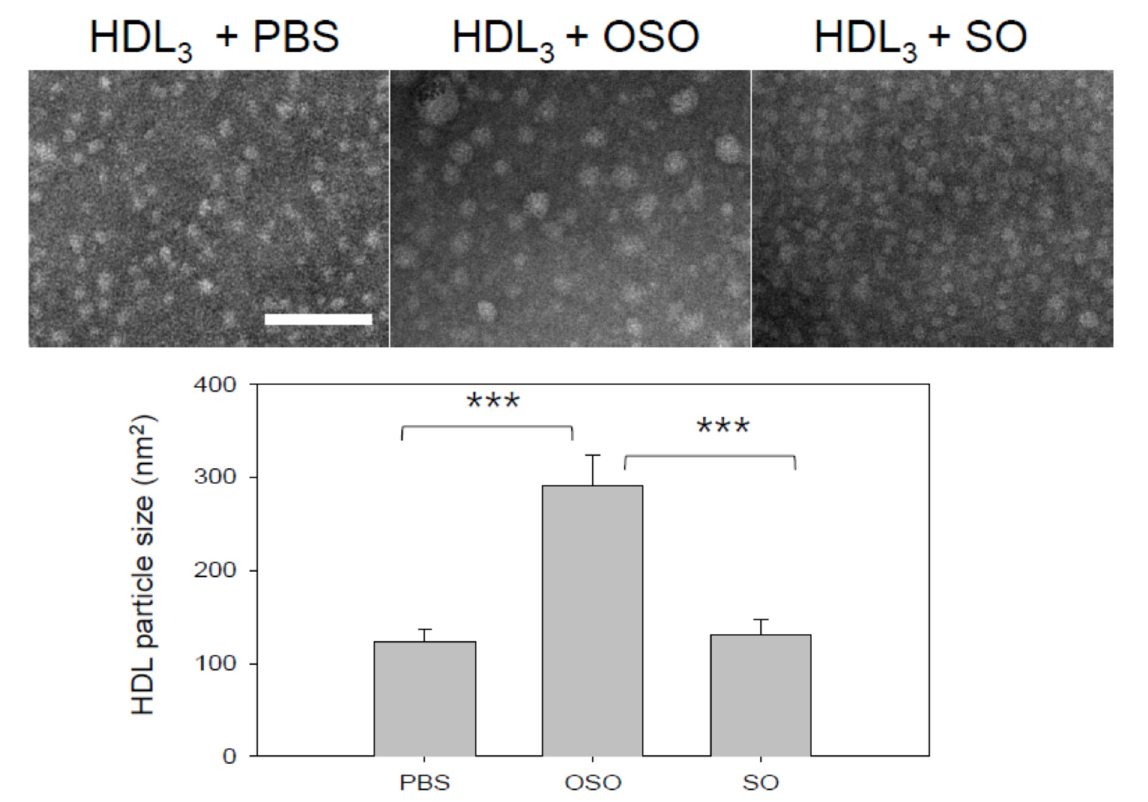
Figure 4. Transmission electron microscopic image of HDL 3 under presence of OSO or SO (final 16%) with magnification of 40,000× g . OSO, ozonated sunflower oil; SO, sunflower oil; PBS, phosphate-buffered saline. *** p < 0.005.